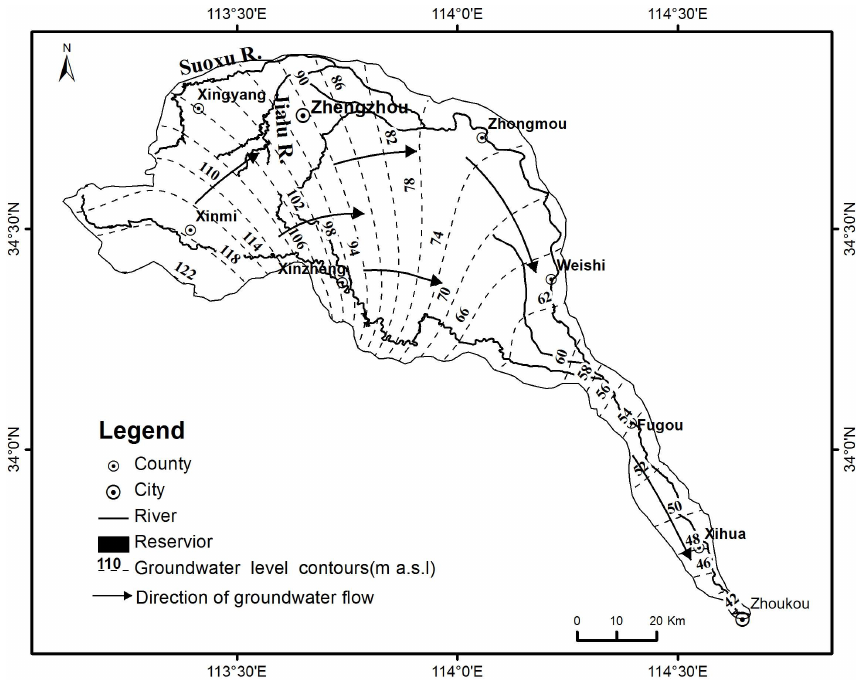
Fig. 4. Shallow groundwater levels in the Jialu River basin based on original source (Yang, 2012). The groundwater level contours (ma.s.l.) are presented at uneven intervals. Arrows indicated the general groundwater